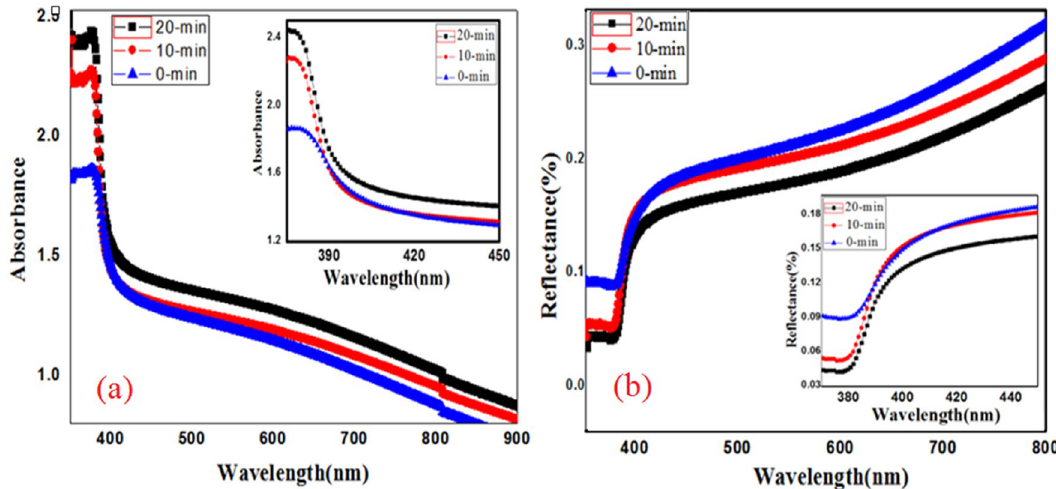
Figure 3. ( a ) Absorbance, ( b ) Reflectance spectra’s along with their fitted insets for clearer of red shift of ZnO- CdO coated films under (10-min and 20-min) irradiation